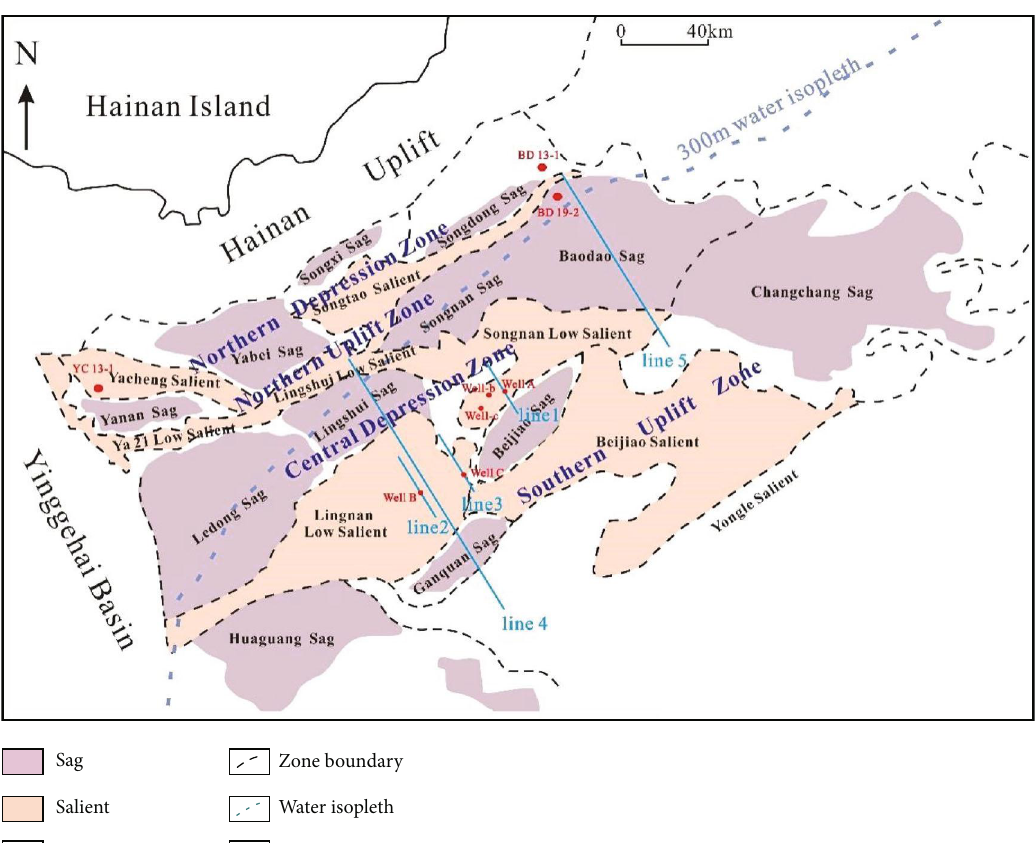
Figure 1: The location and tectonic divisions of the QDNB, SCS (modi fi ed from